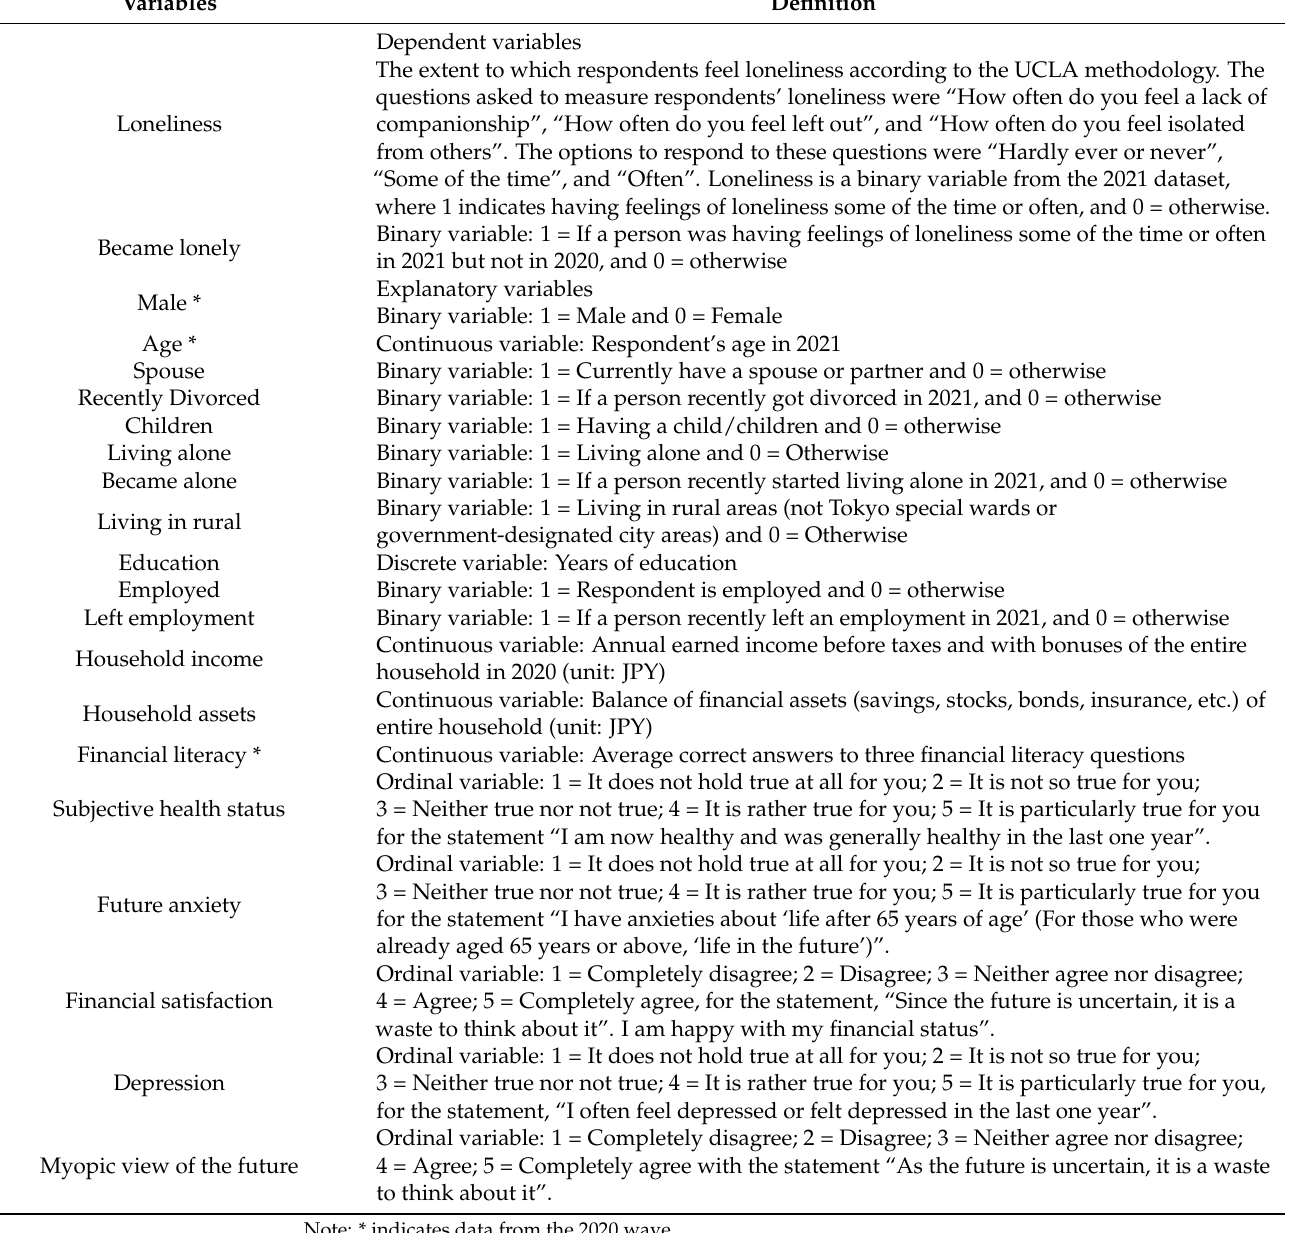
Table 1. Variable